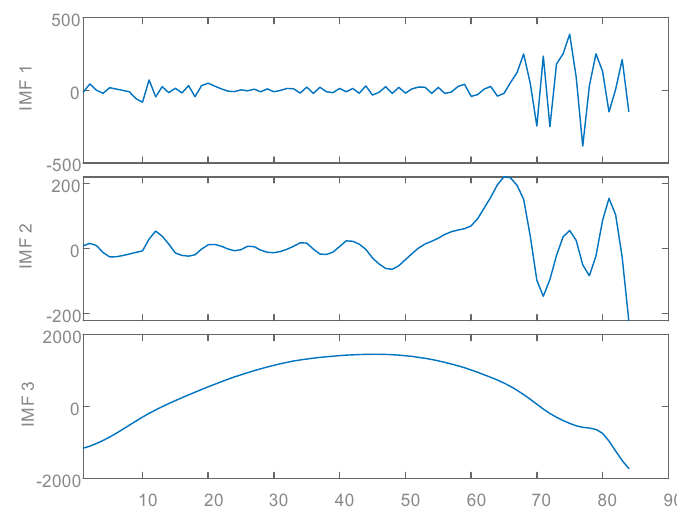
Figure 6. Improved VMD decomposition results of all samples.